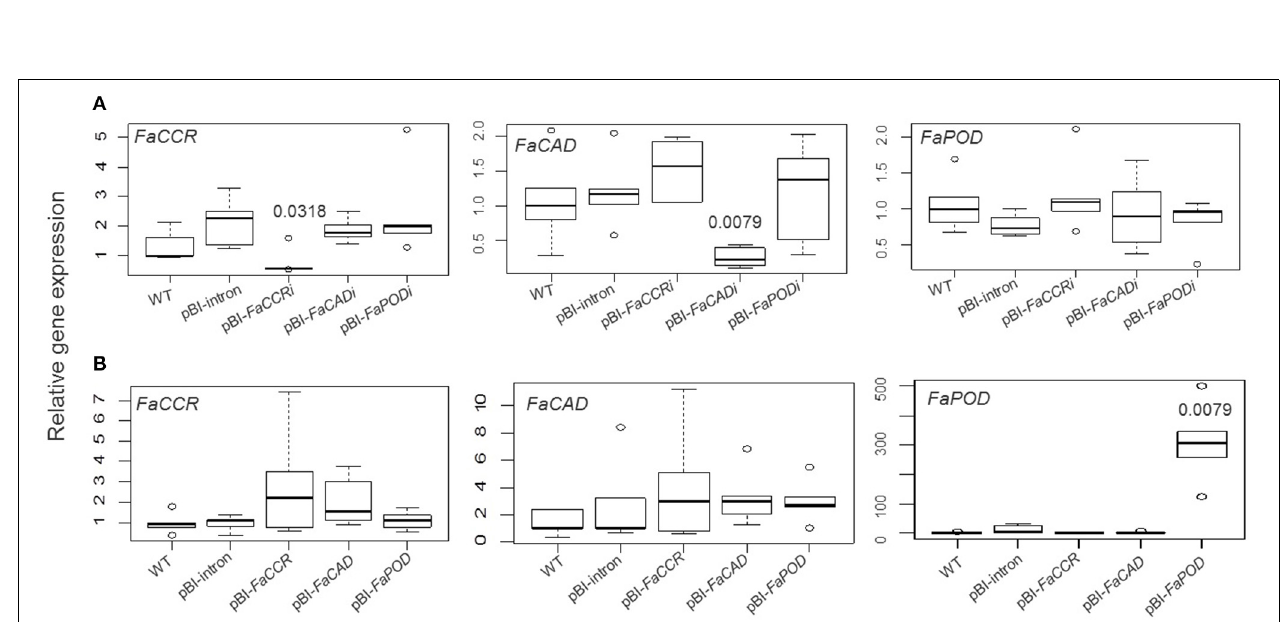
pBI- FaPOD ; n = 43); (C) Lignin content of WT ( n = 14), pBI-intron ( n = 19), pBI- FaCCRi ( n = 19), pBI- FaCADi ( n = 19), and pBI- FaPODi ( n = 19); (D) Lignin content of each group ( n = 10). The statistical analysis methodology used was the Wilcoxon-Mann-Whitney U -test for a non-parametric comparison of two groups. One asterisk ( ∗ ) marked in the box indicates statistically significant increased levels ( P < 0 . 01) in comparison with WT and another group.